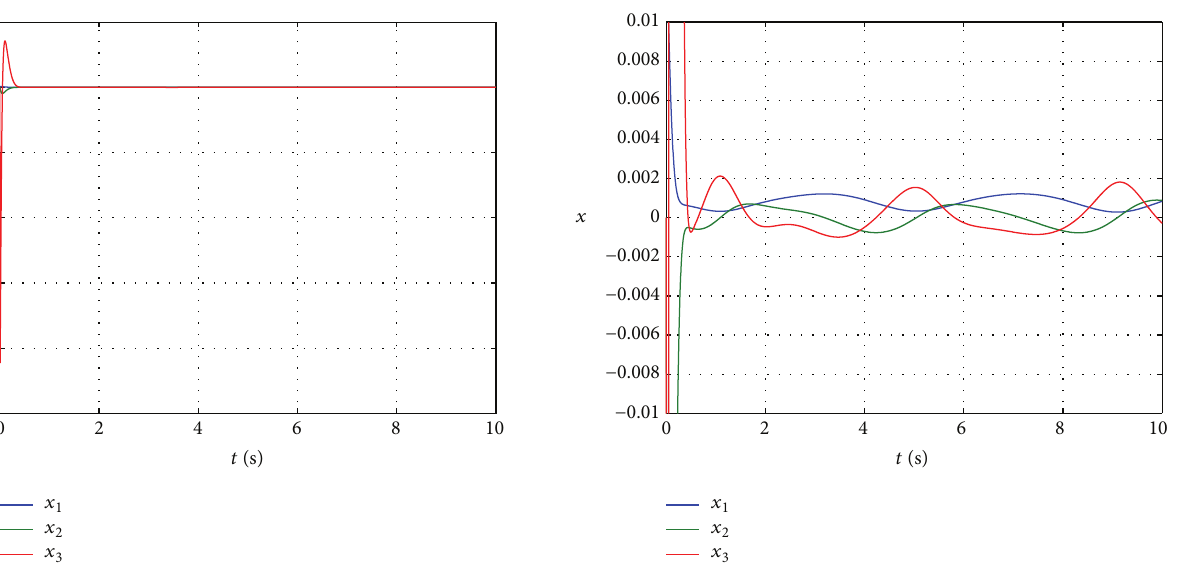
Figure 3: Trajectory of system state x .